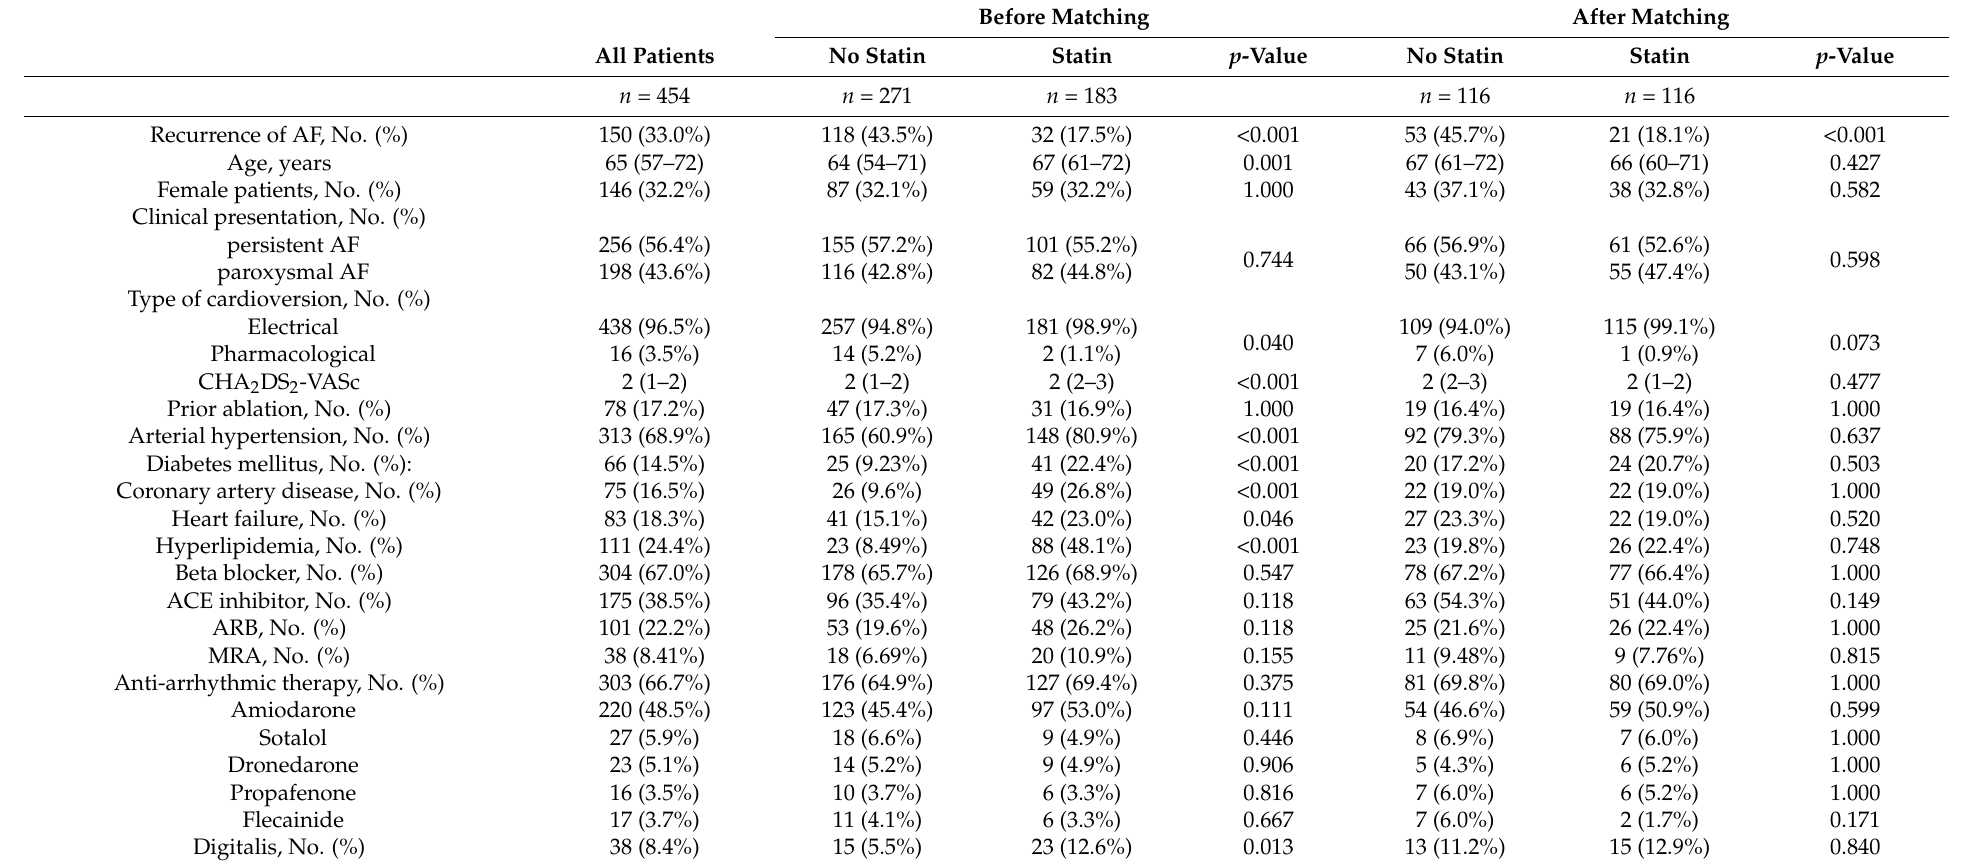
Table 1. Baseline characteristics of study